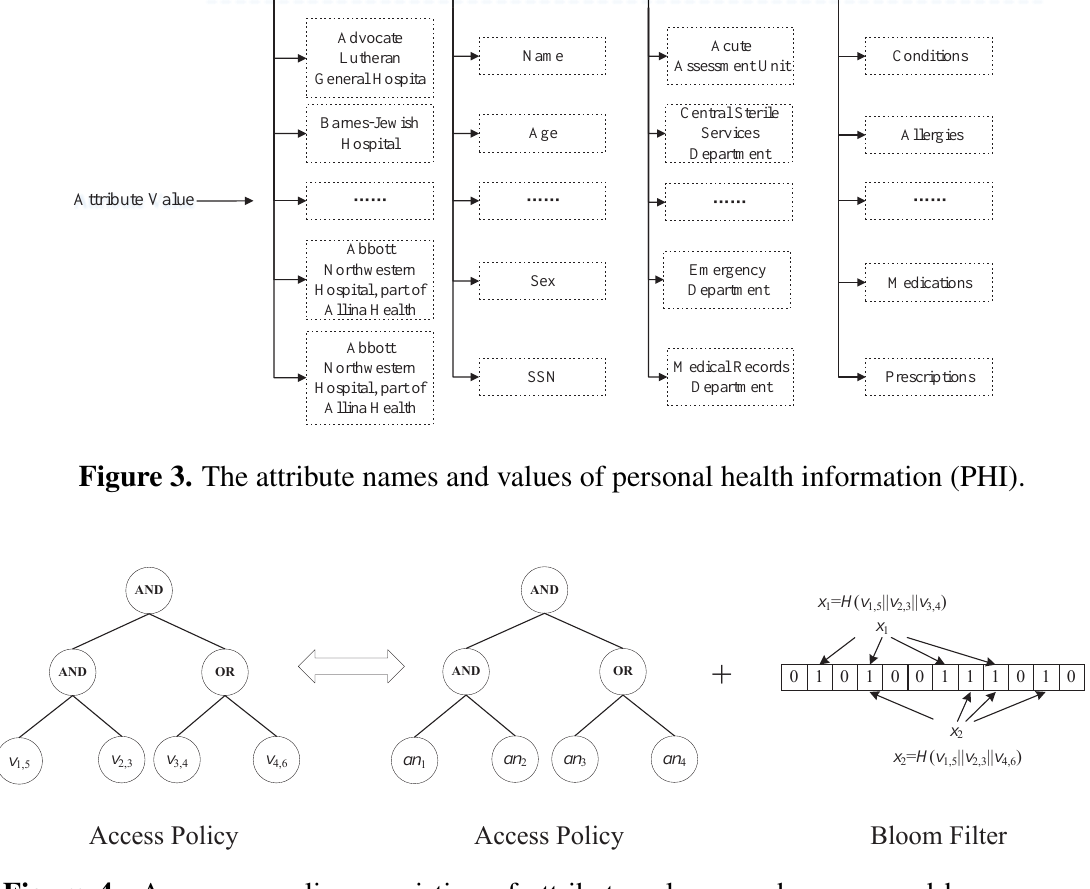
Figure 4. An access policy consisting of attribute values can be expressed by an access policy consisting of attribute names and a Bloom filter consisting of attribute